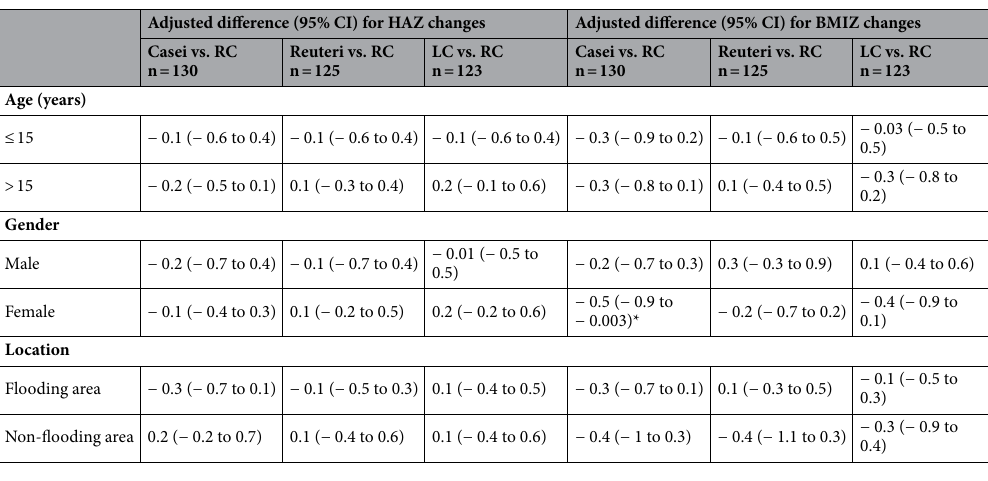
Table 4. Outcomes measurement in adolescents stratified with age, gender, location. BMIZ body mass index- for-age z-score, CI confidence interval, HAZ height-for-age z-score, PAQ-C physical activity questionnaire- children. Generalized linear model was performed in all such values; * p < 0.05.